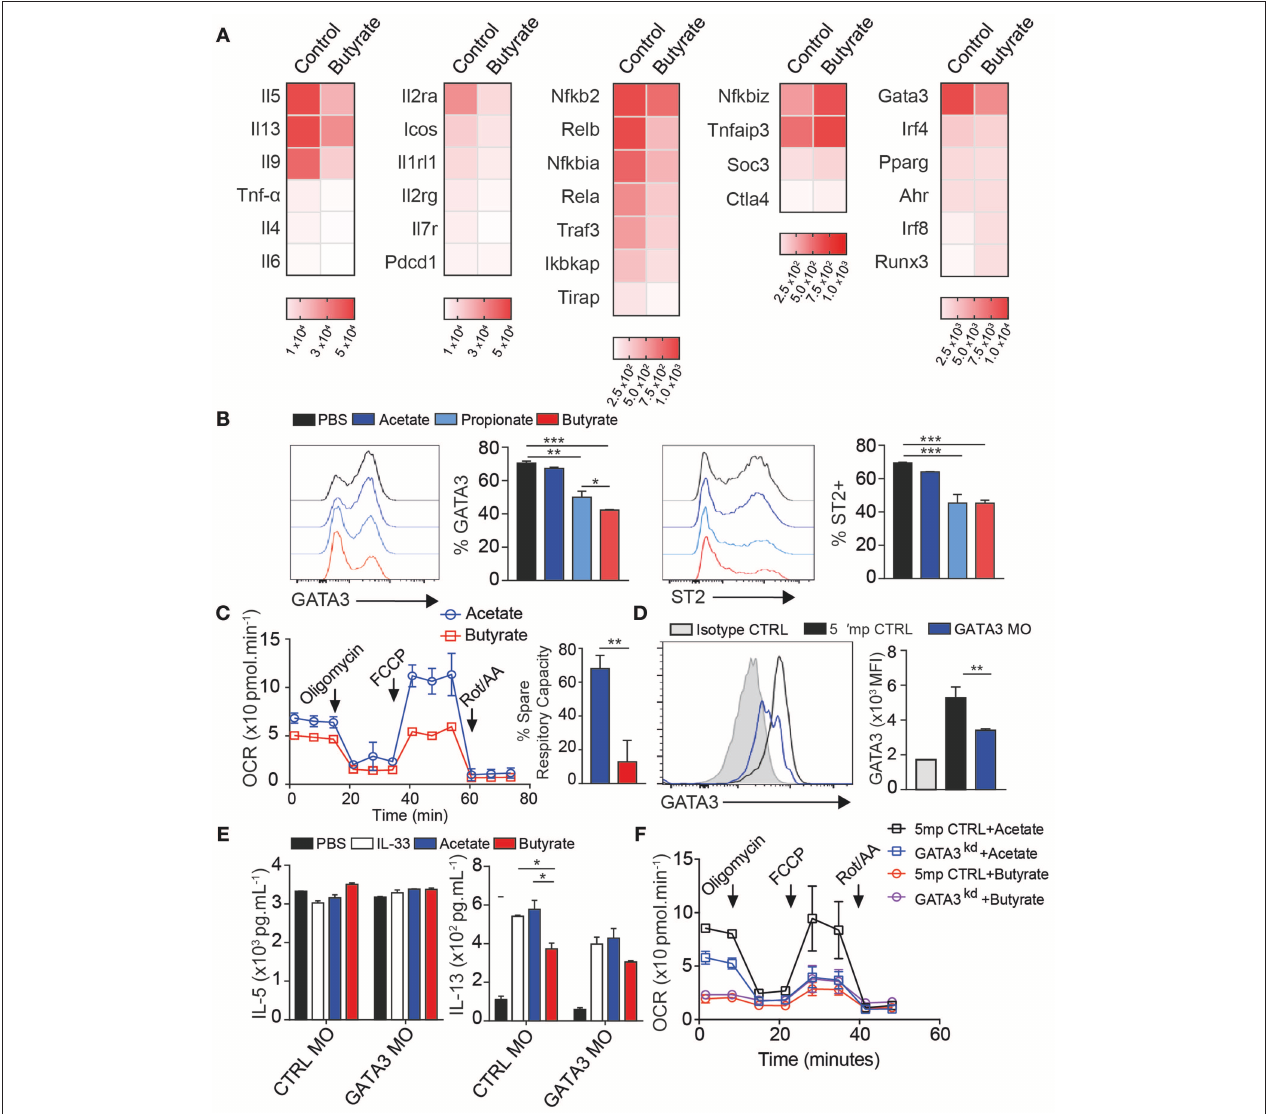
FIGURE 3 | Butyrate regulates GATA3 expression and ILC2 metabolism. Activated ILC2s were FACS purified from lungs after 3 days IL-33 administration i.n. and cultured ex-vivo for 24h in the presence of 200 uM Sodium Butyrate or Sodium Chloride as control for mRNA expression (A) or incubated with indicated SCFA sodium salt at 200 uM for 2–3 days (B–D) . (A) mRNA quantification of immune-related genes by Nanostring panel shown as heatmap of absolute expression counts. (B) Surface expression of ST2 and Intracellular expression of GATA3 in response to indicate SCFA. (C) Oxygen consumption measure (OCR) from Seahorse mito